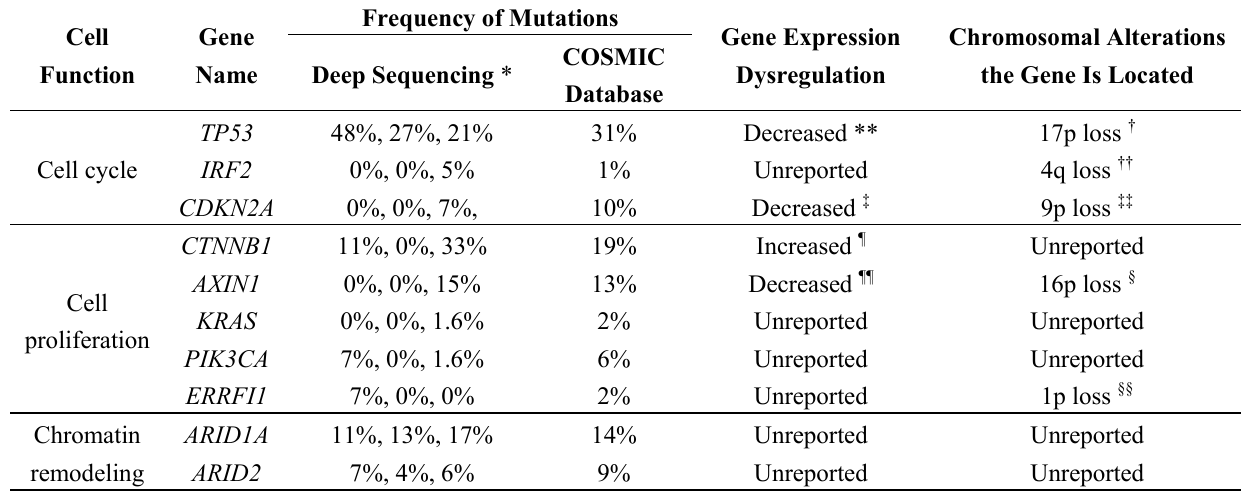
Table 1. Summary of current cancer driver candidates in hepatocellular carcinoma